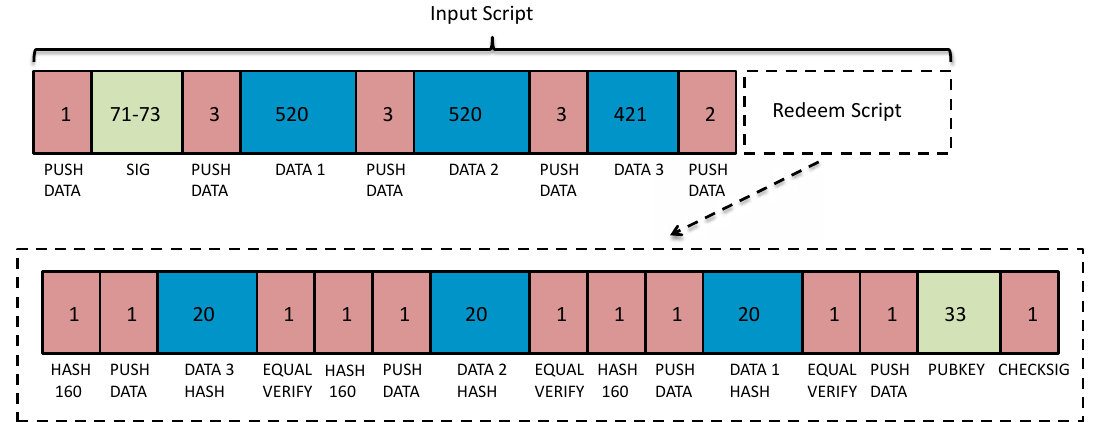
Fig. 6. The anatomy of a maximally-sized input (holding 1461 bytes of arbitrary data) for a Data Hash w/ Sig transaction. It consists of the input script (above) and the Redeem Script (below). The numbers inside the cells label the number of bytes for each field. Red fields denote OP codes, dark blue fields denote the arbitrary data chunks being inserted (and the hashes of that data), and the light green fields denote the signature-related data (omitted for the w/o Sig